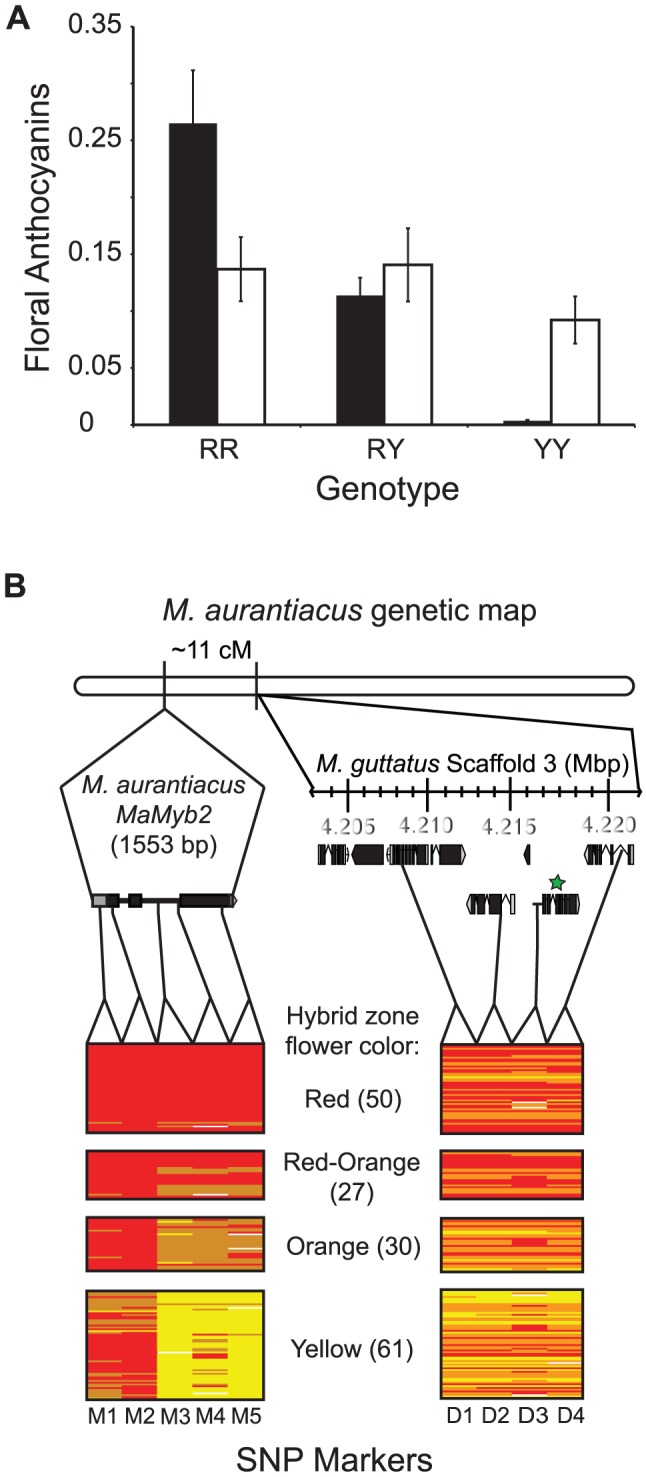
Genetic mapping implicates MaMyb2 in the flower color change.
(A) Among 79 recombinant F2 hybrids, genotype at MaMyb2 (black bars) predicts floral anthocyanin content (F2,76 = 20.66; P<0.0001), but genotype at MaDfr (white bars) does not (F2,76 = 0.53; P = 0.59). Error bars indicate one standard error. (B) From 168 naturally-occurring hybrid plants, the relationship between genotype (RR = red bars; RY = orange bars; YY = yellow bars; missing data = white bars) and flower color is shown for SNP markers in MaMyb2 (M1–M5) and surrounding the linked MaDfr (D1–D4). The genetic map in M. aurantiacus is shown, demonstrating that MaMyb2 and MaDfr are separated by 11 cM. Insets depict the physical positions and gene structures (boxes = exons; lines = introns) of the M1–M5 and D1–D4 markers on different scales. Relative positions of the markers were identified either by sequencing MaMyb2 in M. aurantiacus (1553 bp) or from scanning the M. guttatus genome assembly (v. 1.1) scaffold 3 that contains MgDfr (region spanning ∼15 kb). All markers were linked to each other and to MaDfr in M. aurantiacus. The green star indicates the MaDfr gene. Functional annotations for the genes containing markers D1–D4 are described in Table S3.